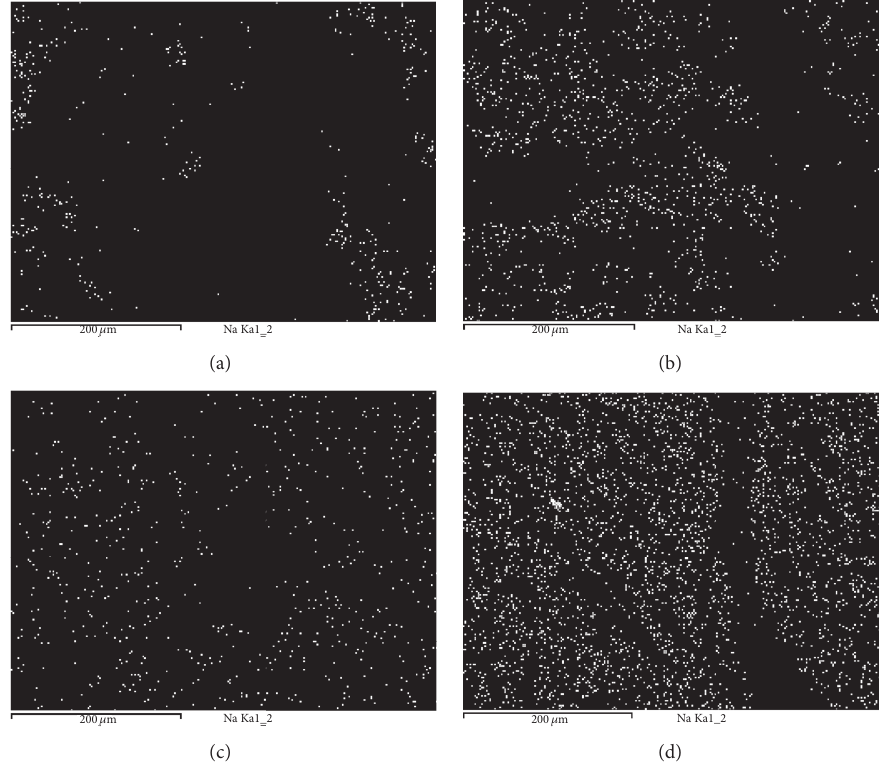
Figure 2: Distribution of sodium in beef samples (longissimus dorsi) . (a) Marinated traditionally for 60 min without storage. (b) Marinated traditionally for 60 min and storage for 7 days. (c) Marinated using ultrasound for 60 min without storage. (d) Marinated using ultrasound for 60 min and storage for 7